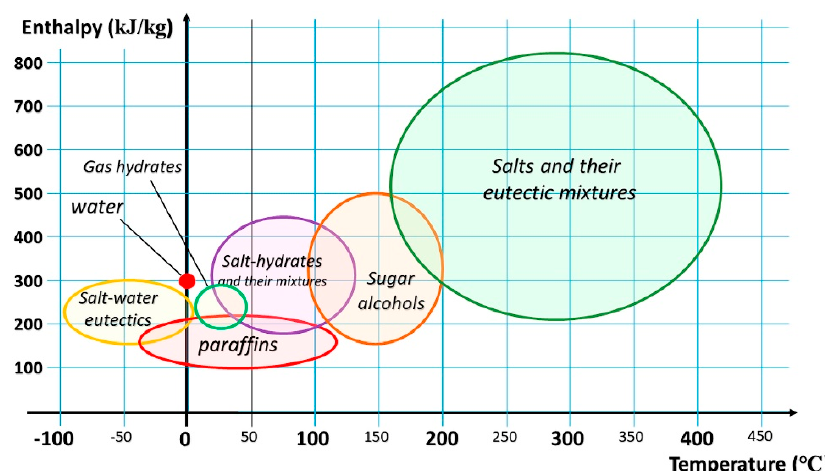
Figure 6. Temperature and enthalpy ranges for various PCMs